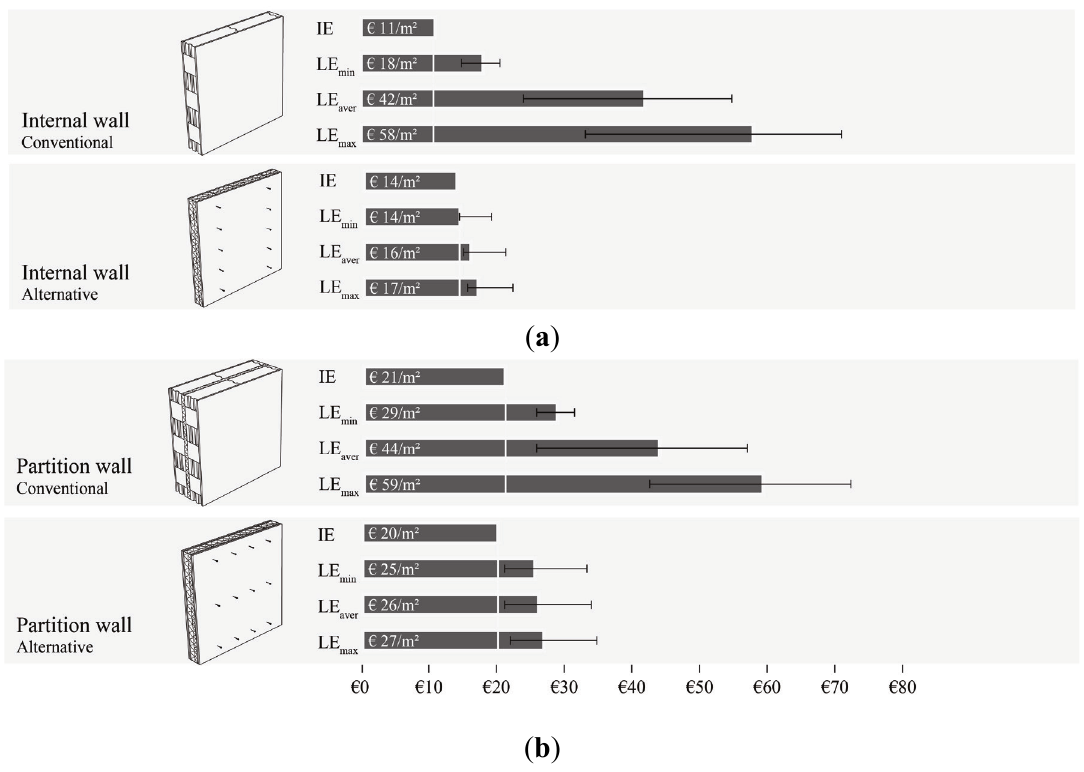
Figure 5. The outcomes of the life cycle assessment of the ( a ) internal and ( b ) partition wall show that the demountable construction assembly has the lowest life cycle environmental impact in those scenarios with average and maximum refurbishment frequencies, with IE as initial environmental impact, LE min as life cycle impact with no refurbishments, LE aver as life cycle impact with an average number of refurbishments, LE max as life cycle impact with a maximum number of refurbishments during 60 years. The error bars represent the results of the sensitivity analysis on a variable lifespan of the building (from 30 to 79